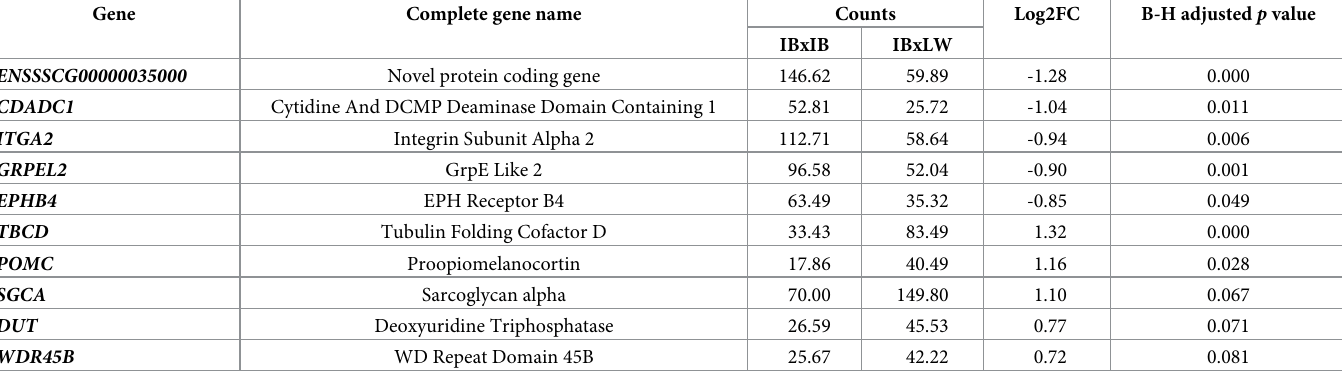
Table 6. Ten most significant differentially expressed genes (B-H adjusted p value < 0.1) calculated with DESeq2 in hypothalamic transcriptome samples of 60 days-old pure Iberian and Iberian x Large White crossbred male